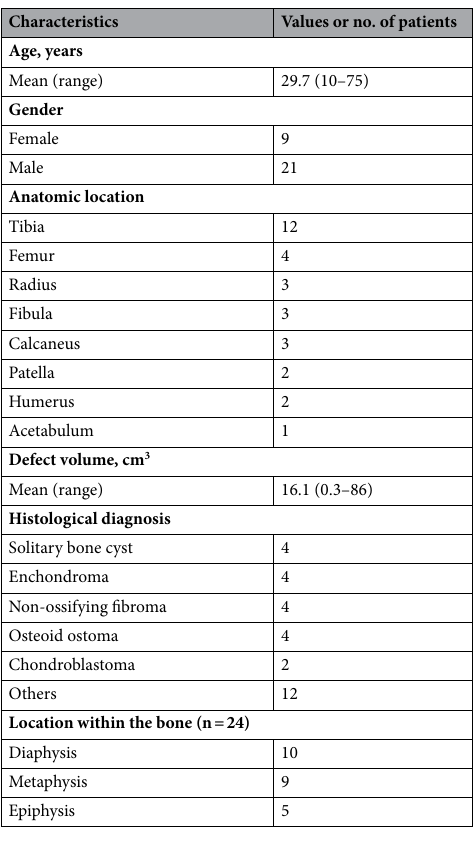
Table 1. Demographic data of 30 patients in cohort 1.